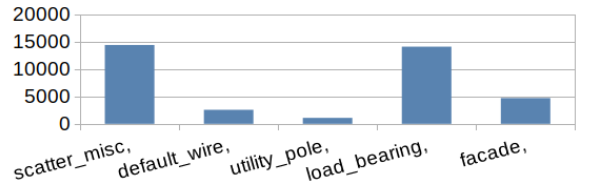
Figure 3. Label distribution in trainings